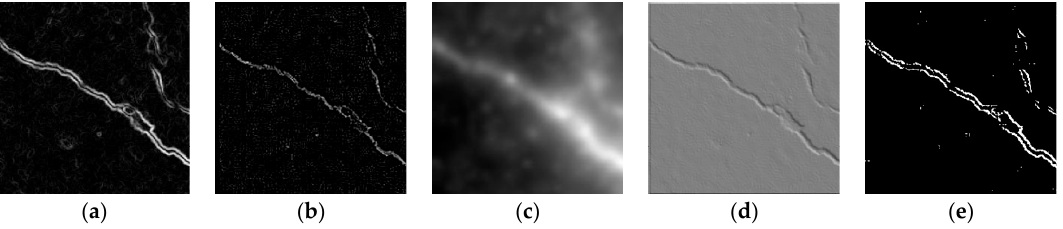
Figure 6. Crack edge detection results of image with oblique crack using different filters: ( a ) Sobel; ( b ) LoG; ( c ) Gabor; ( d ) steerable; ( e ) homogeneity.